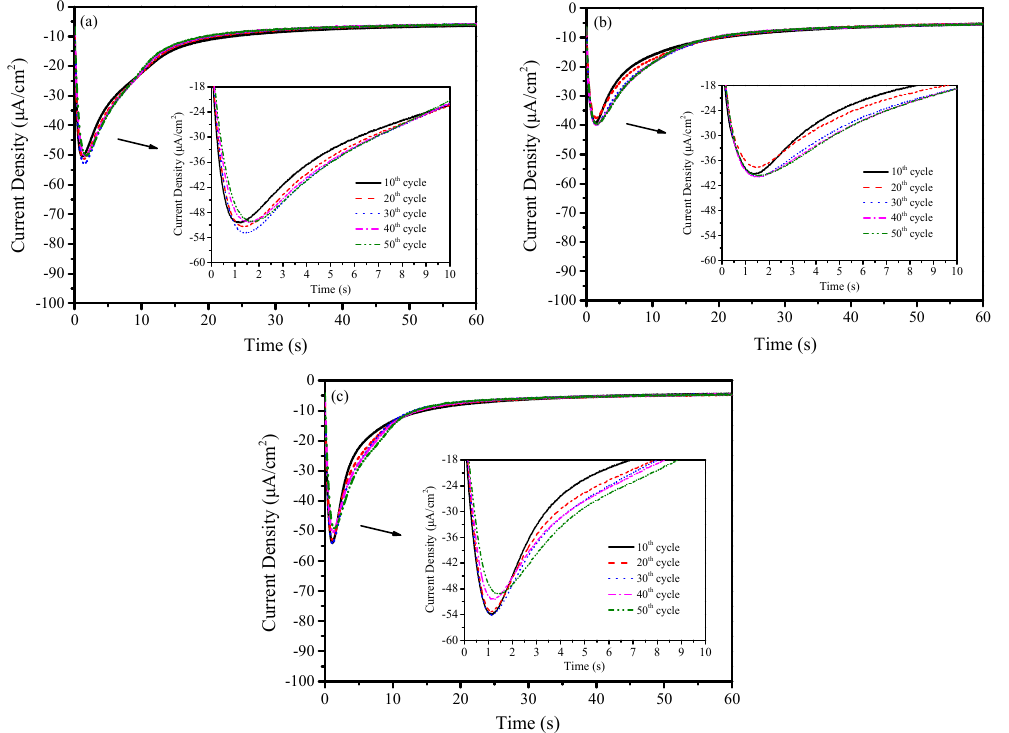
Figure 3. Current density–time curves for the UPD-Mn deposited at − 800 mV for 60 s, and that were subsequently replaced by Cu 2 + during the Cu-SLRR, terminated at a time of ( a ) 60 s, ( b ) 40 s, and ( c ) 20